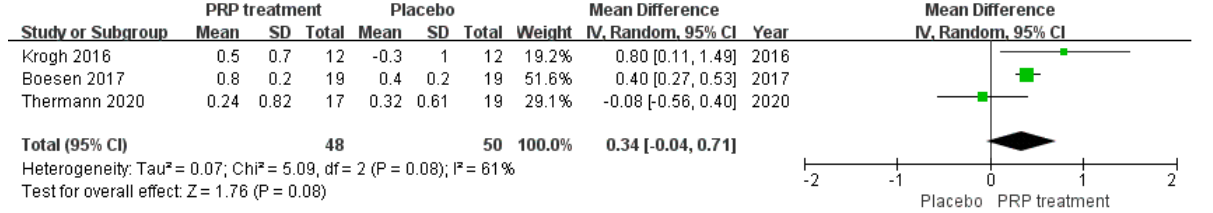
Figure 6. Forest plot of Achilles tendon thickness variation. VAS